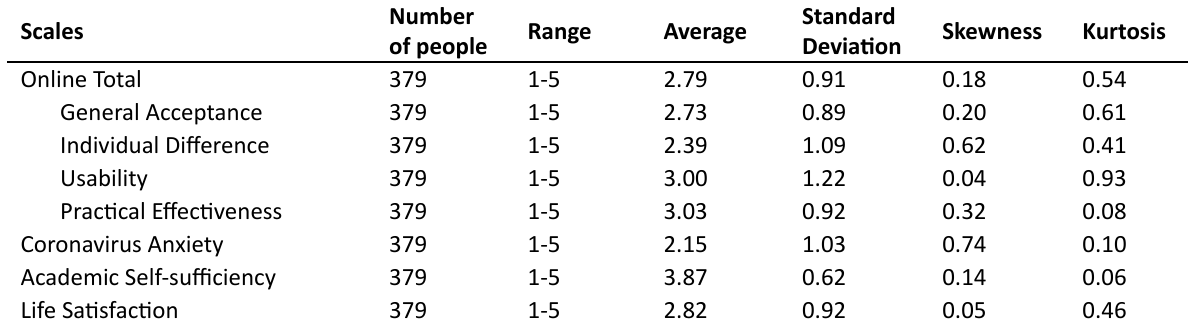
Table 1. Descriptive statistical results for variables Scales